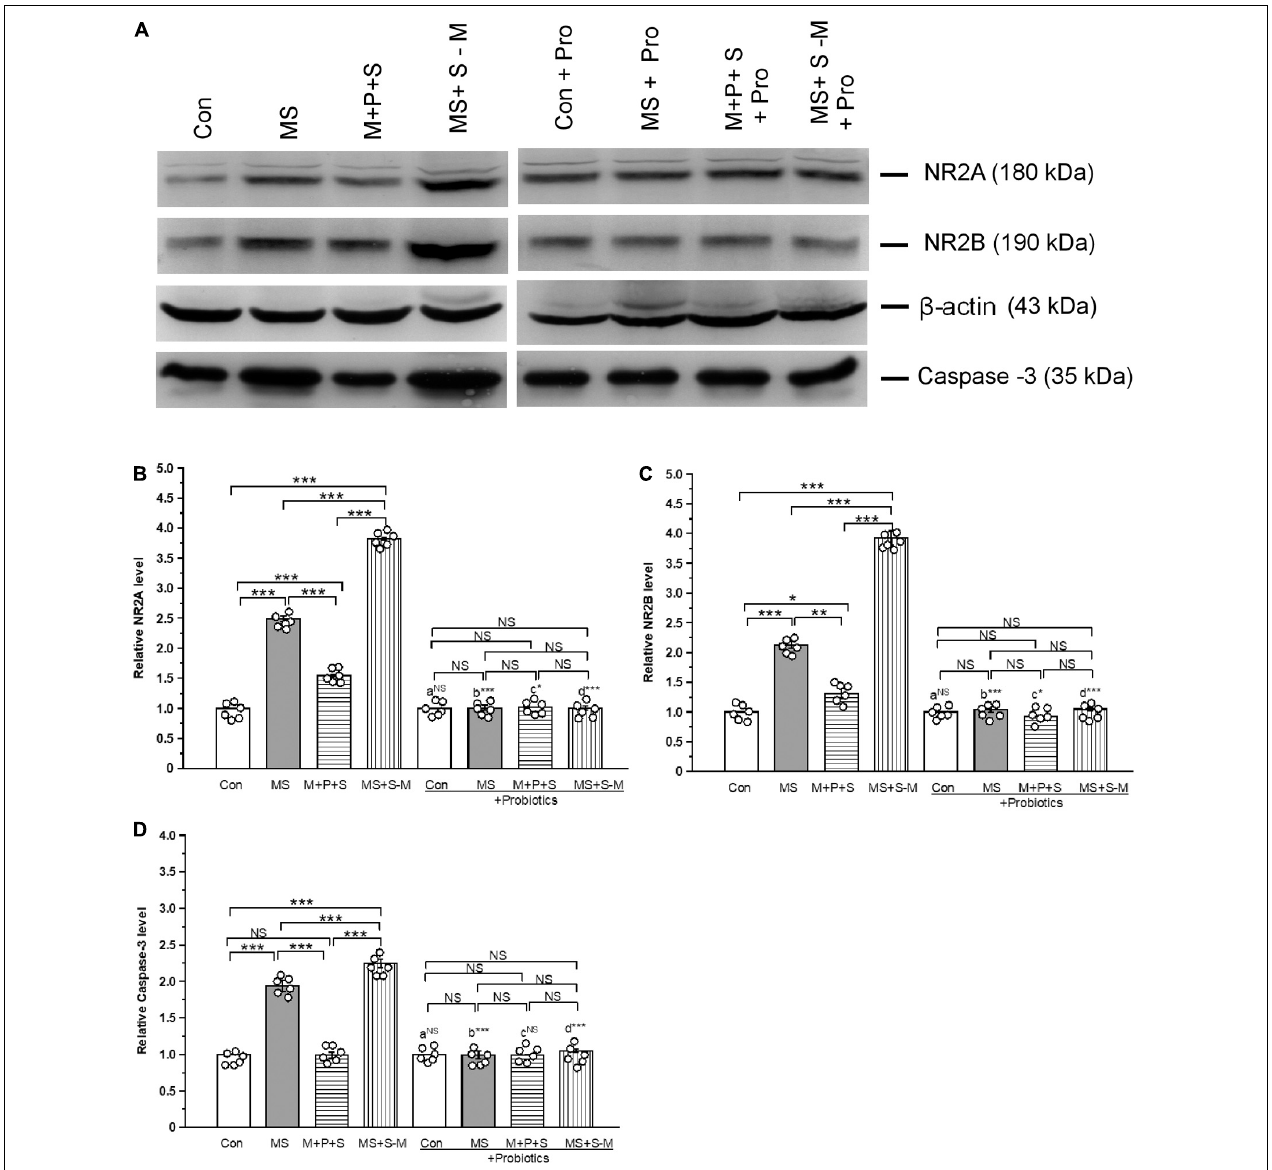
FIGURE 9 | Lactobacillus supplementation prevented early-life SSE induced changes in NMDA receptors and caspase-3. Representative western blots showing the alternations in NR2A, NR2B, and Caspase-3 (A) . The relative level of expression of NR2A (B) and NR2B (C) and Caspase-3 (D) increased after the individuals experienced social stress. Values are presented as mean ± SEM. Significant differences between groups are indicated by *** P < 0.001, ** P < 0.01, * P < 0.05; a: con vs. con + Pro; b: MS vs. MS + Pro; c: M + P + S vs. M + P + S + Pro; d: MS+S–M vs. MS+S–M + Pro; NS, not